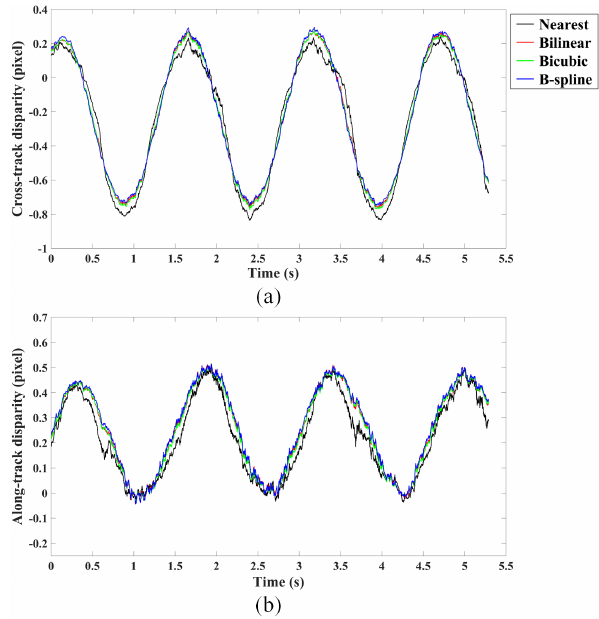
Figure 4. Averaged disparity curves a) in the cross-track direction and b) in the along-track direction calculated from dense image matching with different